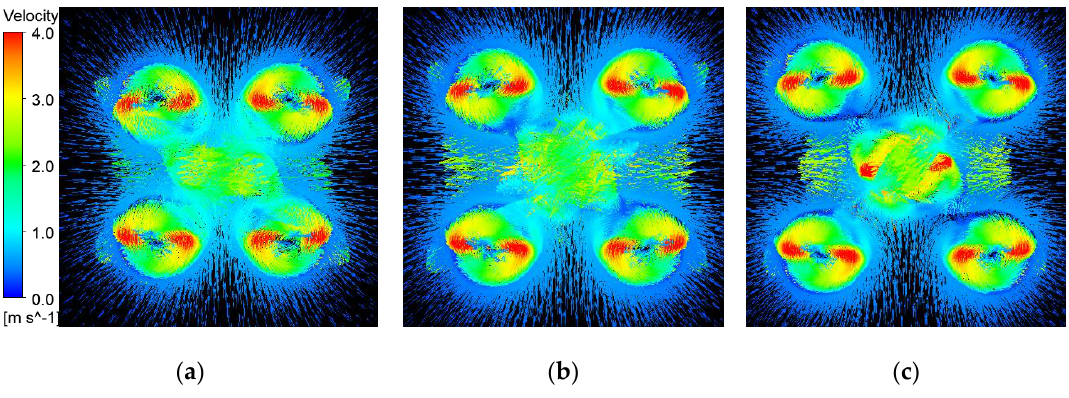
Figure 10. Velocity contours at Re = 0.89 × 10 5 . ( a ) i = 0.71; ( b ) i = 0.63; ( c ) i = 0.56.